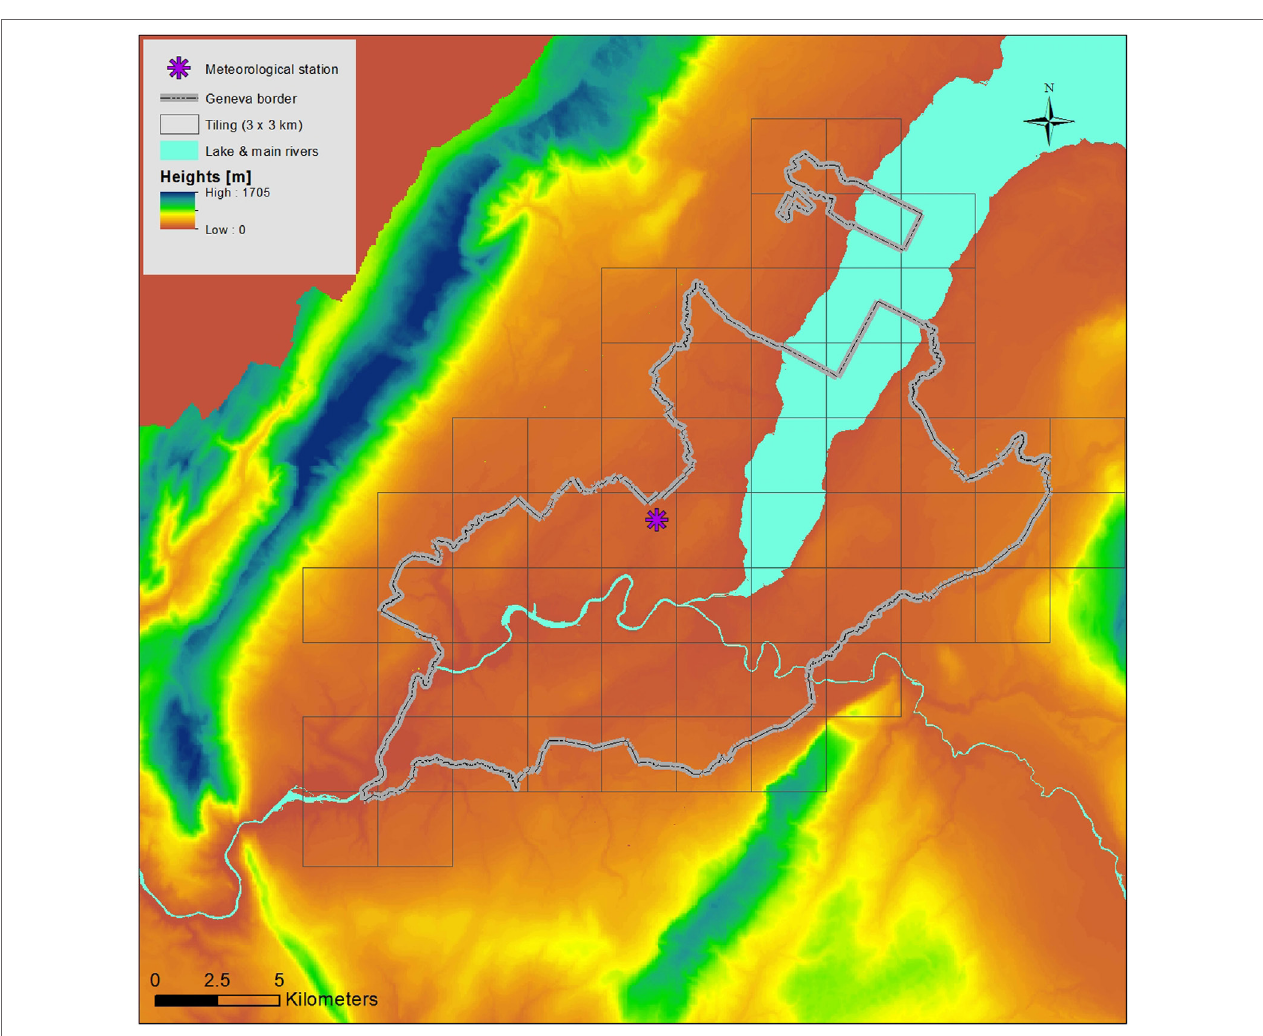
FIGURe 6 | Agglomeration of Geneva highlighting the relief, the meteorological reference station, and the tiling